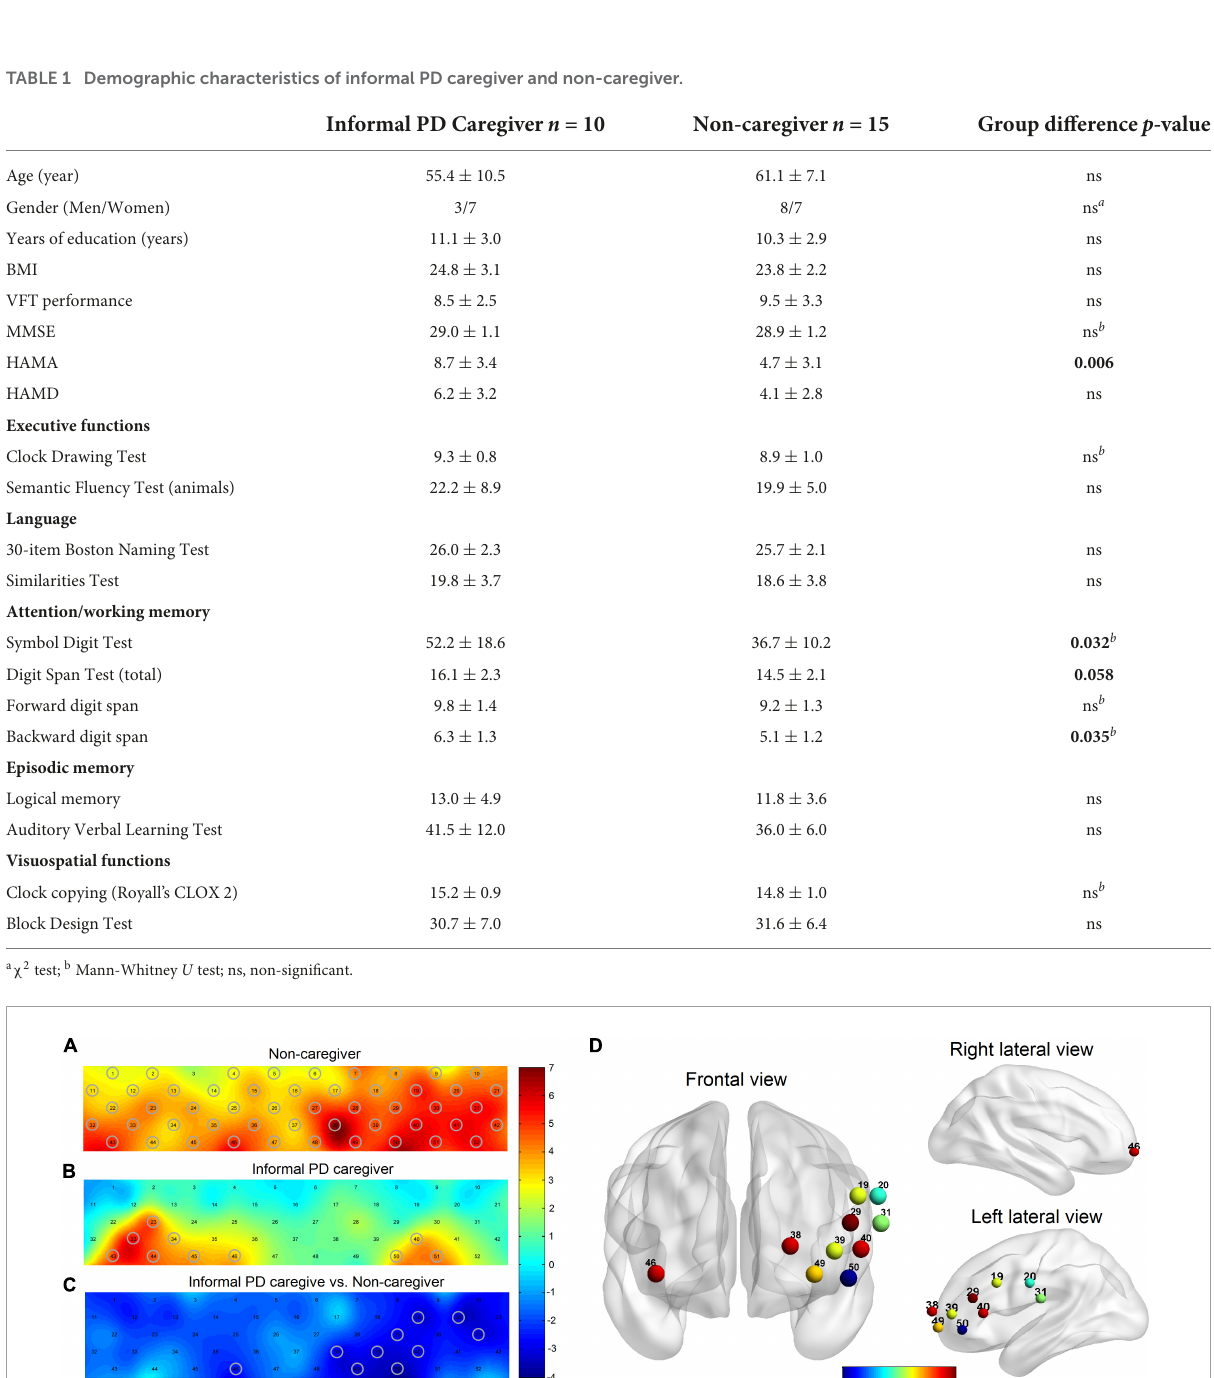
Drawing Test was positively correlated with the RSFC between the right VLPFC and the right IPL, the left DLPFC and the right VLPFC, the mPFC and the right VLPFC, the left TL and the